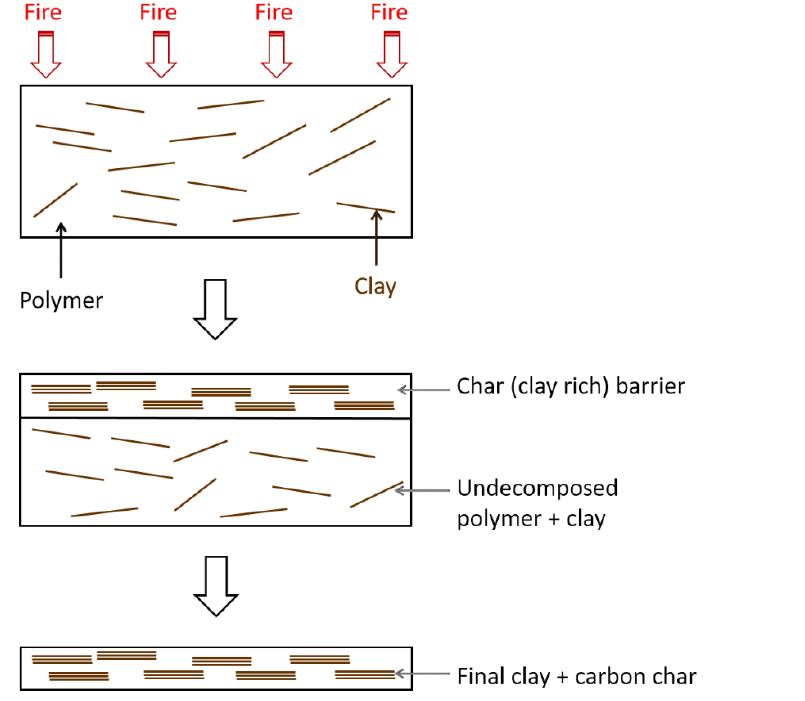
Figure 15. Polymer nanocomposite flame-retardant process, which decreases the HRR by char acting as a barrier. Reprinted with permission from Ref. [49]. Copyright 2012, John Wiley & Sons, Ltd.